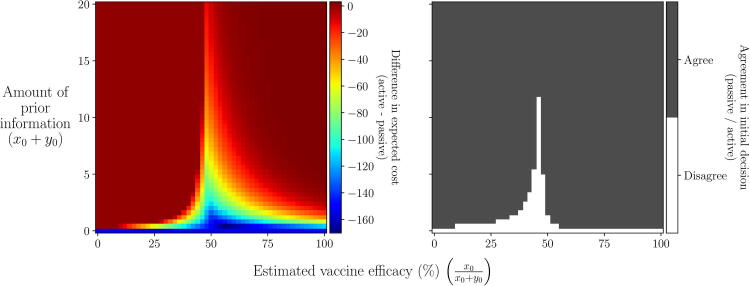
Scenario 1: Comparison of initial decision made between active and passive AM given different prior information. We define prior information using a Beta(x0+1,y0+1) distribution and vary the estimated efficacy (the mode of the distribution; x0x0+y0) and the amount of information supporting this estimate (x0+y0). Left panel: difference in expected cost under active AM compared to passive AM. Right panel: agreement in initial decision between passive AM and active AM. Epidemiological and vaccination parameters are set to those in Table A.2: Scenario 1.